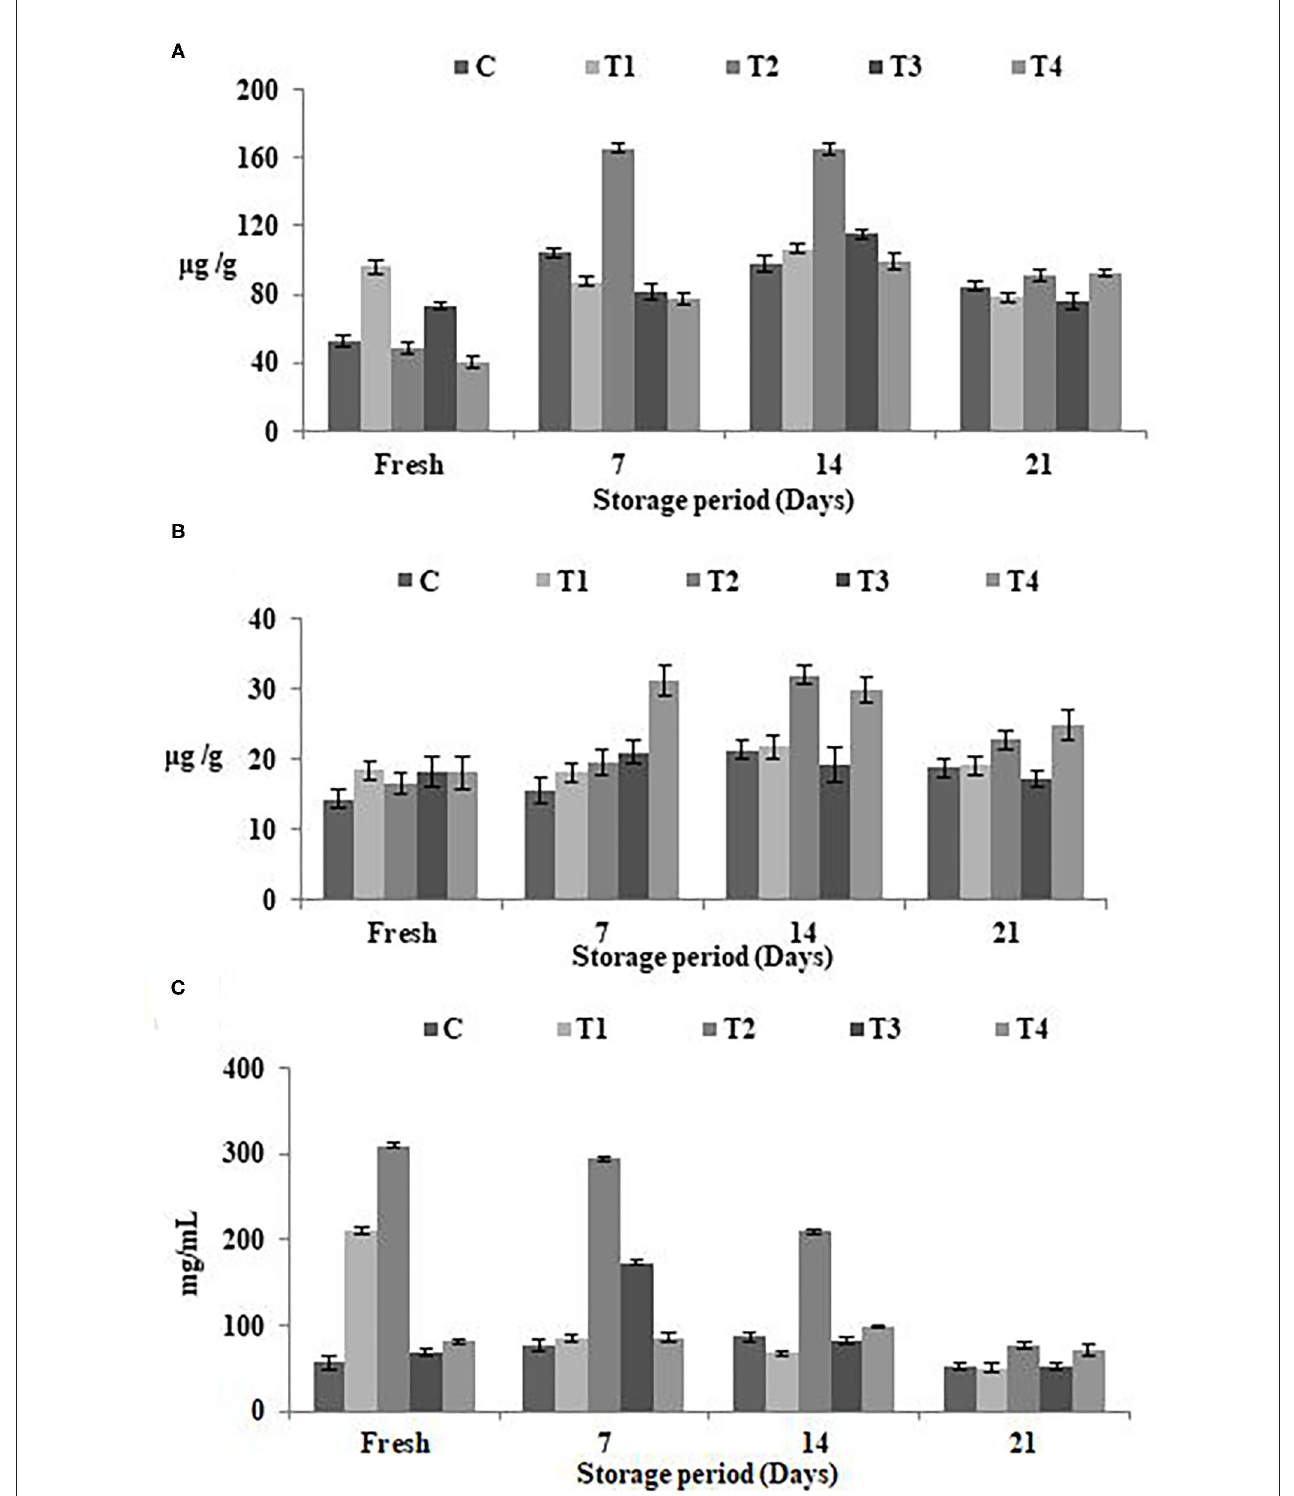
FIGURE 3 | Phenolic, flavonoid content, and antioxidant potentials in SFY during storage. (A) Total phenolic content (TPC) ( µ g gallic acid equivalents/g sample). (B) Total flavonoid content (TFC) ( µ g catechol equivalents/g sample). (C) Antioxidant potentials represented as IC 50 (mg mL − 1 ), the inhibitory concentration at which 50% of DPPH radical is scavenged. Data represented are means of duplicates ± SD. C, Control plain SFY; T 1 , SFY fortified with free Fe + ascorbic acid; T 2 , SFY fortified with free Fe + FA + ascorbic acid; T 3 , SFY fortified with Fe@BSA-NPs + ascorbic acid; T 4 , SFY fortified with Fe + FA @BSA-NPs + ascorbic acid. BSA-NPs, Bovine Serum Albumin nanoparticles; FA, Folic